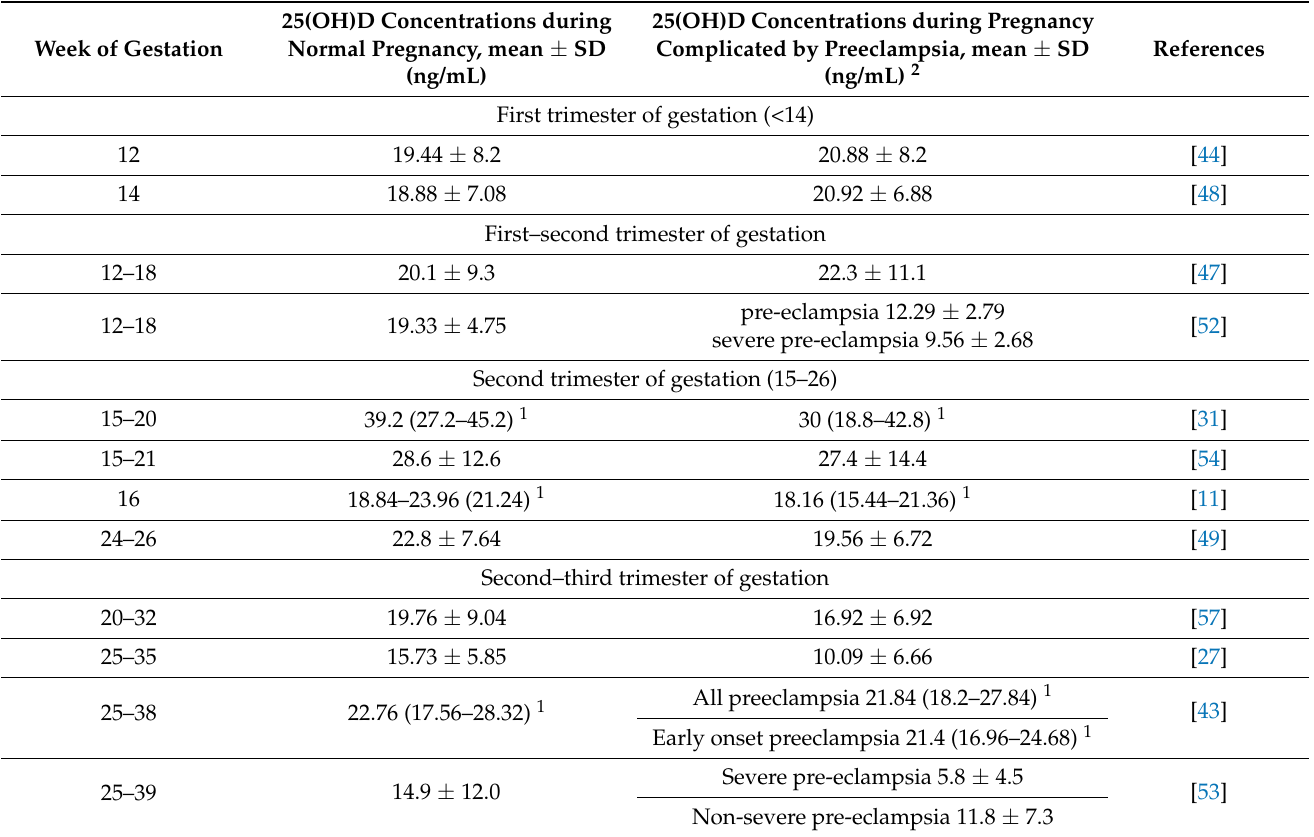
Table 1. Concentrations of 25(OH)D during normal and complicated by preeclampsia